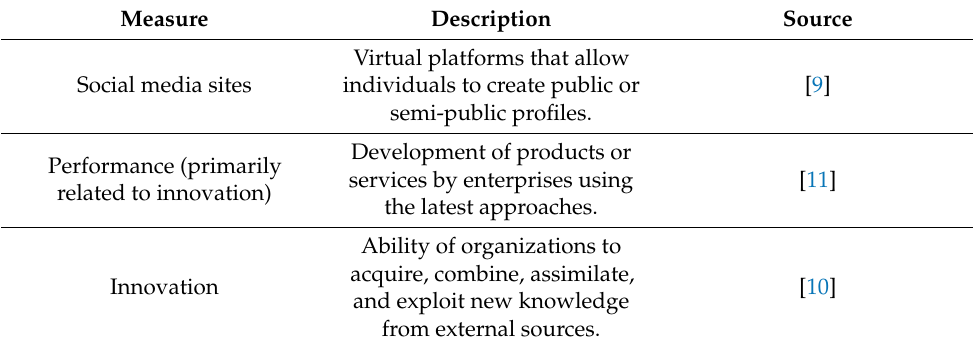
Table 1. The measures, descriptions, and sources of variables used in the questionnaire.